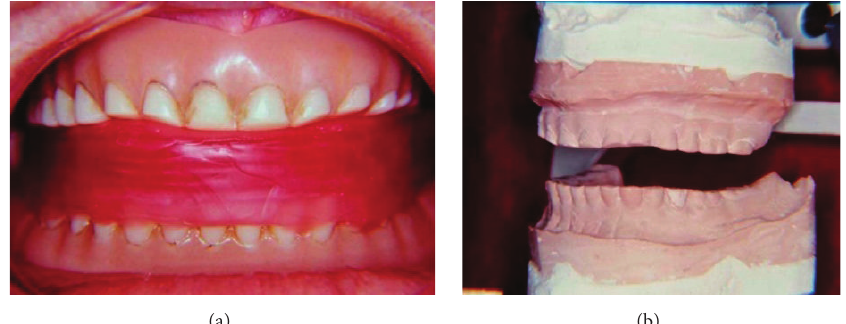
Figure 2: Record for reestablishment of 14 mm in the OVD. (a) Record in wax with 14mm; (b) second master cast set mounted in a semiadjustable articulator.